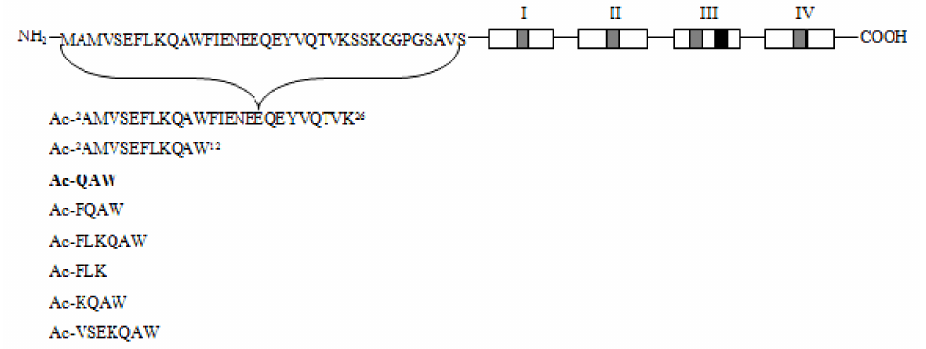
Figure 4. Schematic representation of Annexin protein and derived